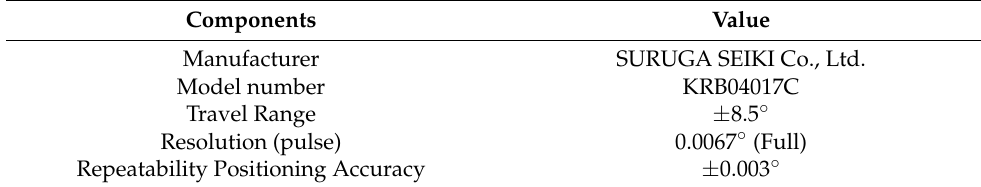
Figure 9. Experimental result of noise level using the standard deviation of the center-of-gravity wavelength calculation for each data point. Table 5. The experimental results of the proposed angle measurement system. Standard Deviation 2 s (nm)